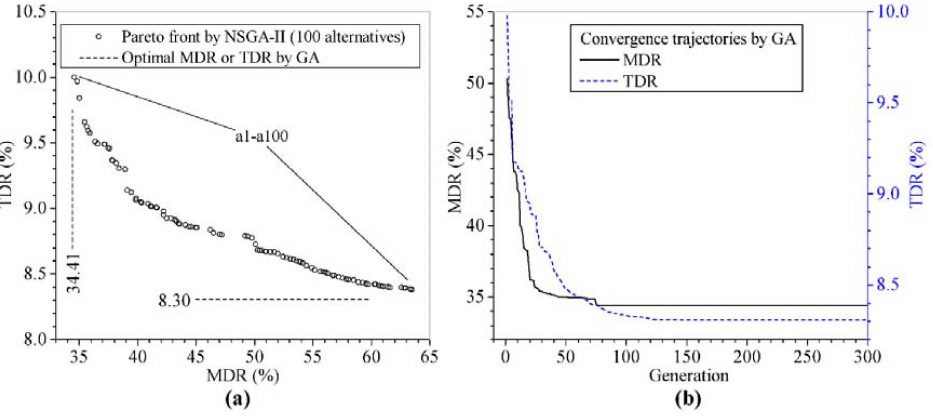
Figure 8. ( a ) The decision space A derived by NSGA-II; ( b ) results of single-objective optimizations obtained by